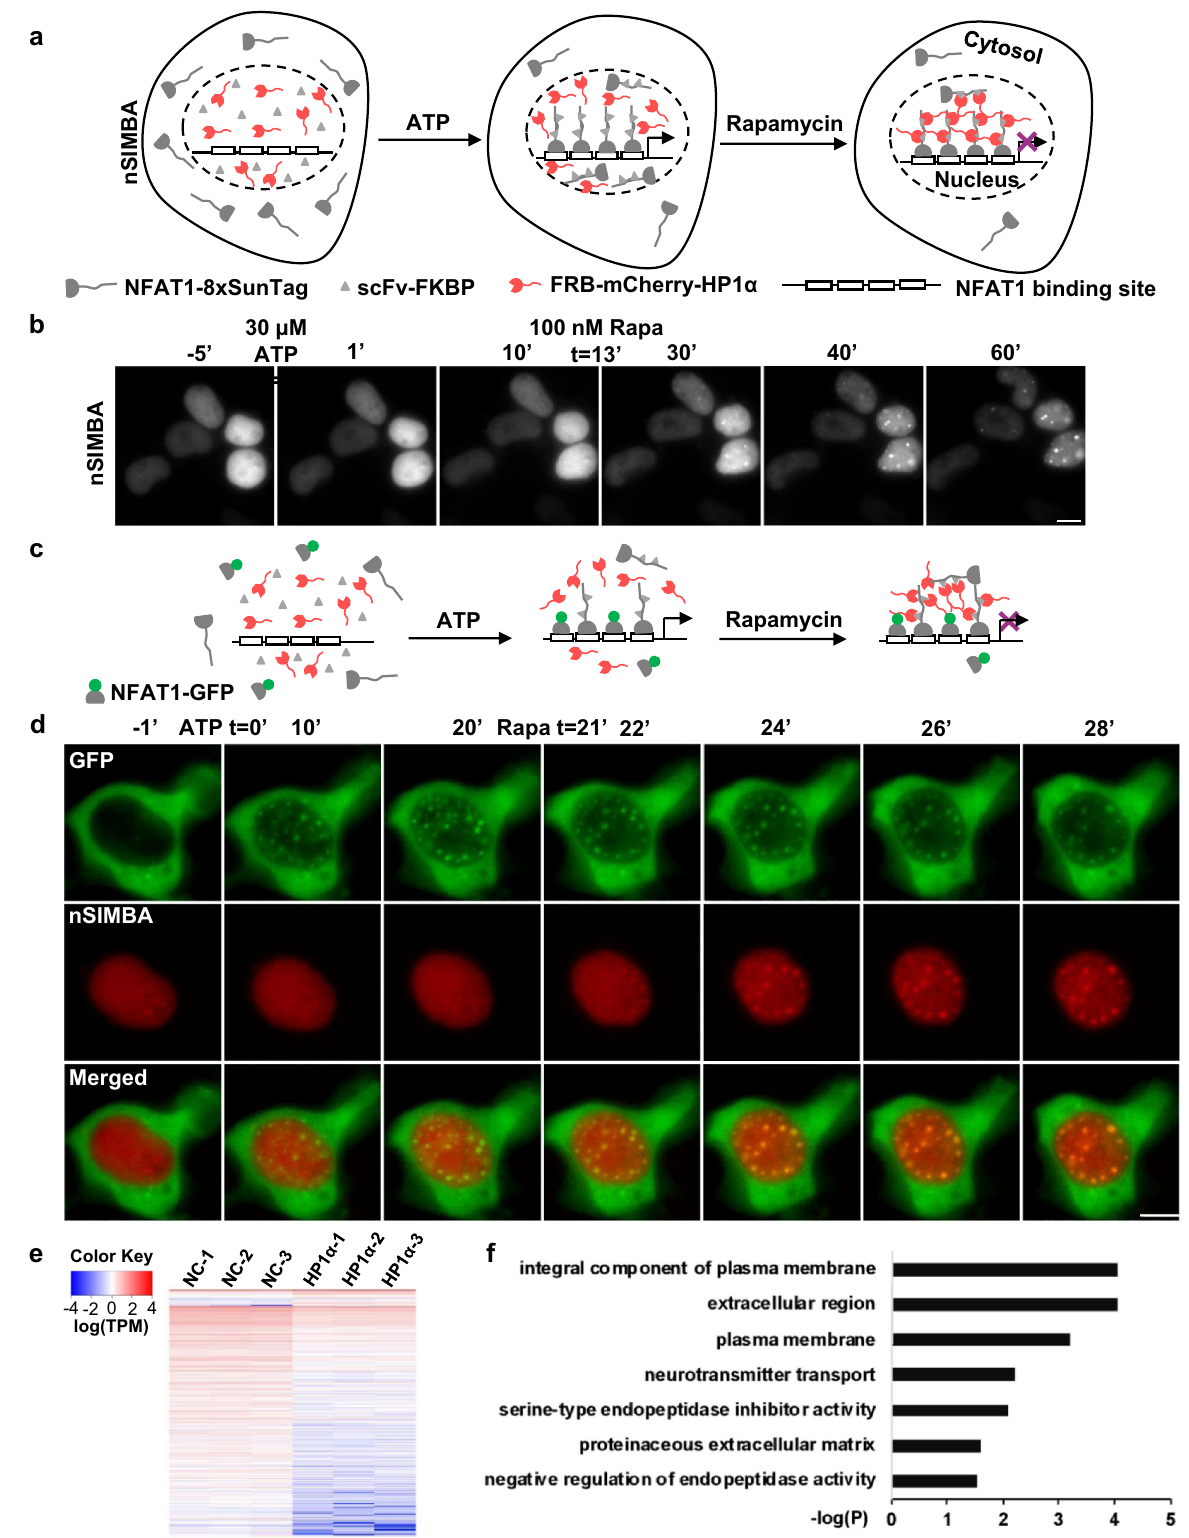
H3K9me3 at the local chromatin for the formation of suppressive chromatin structure 12 . SIMBA can also be guided by endogenous transcription factors, such as NFAT1 (Fig. 4), to perturb the innate signaling and cellular functions mediated by these regulators. As such, SIMBAcan be applied to track, in principle, any genomic locus in living cells, and manipulate the corresponding gene expression. Our